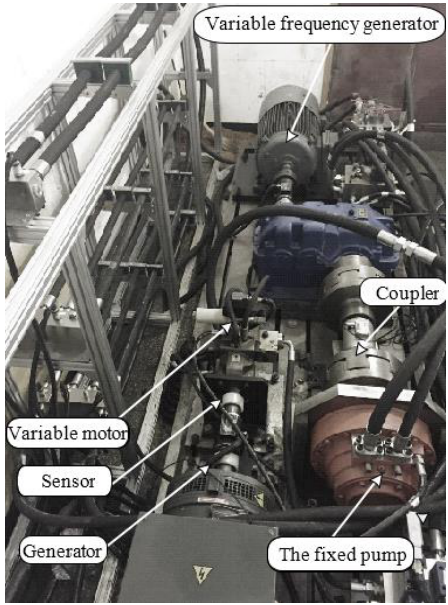
Figure 13. Physical layout of the 30 kVA HWT experimental platform.